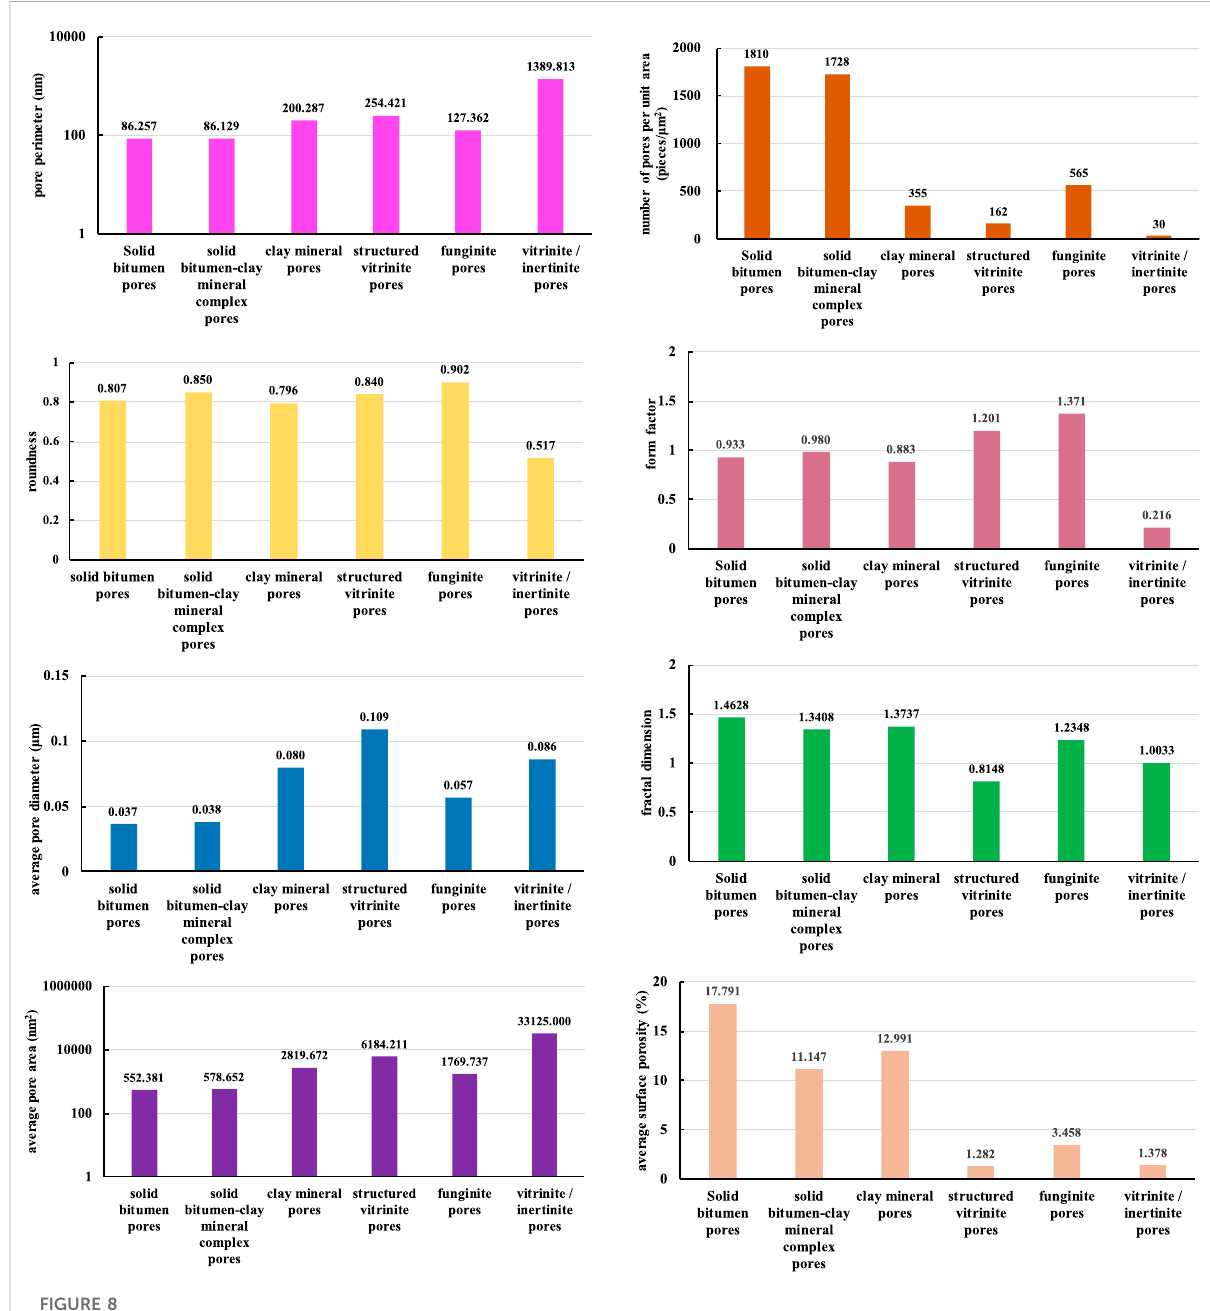
FIGURE 8 QuantitativecharacterizationofporecharacteristicsofshalewithdifferentmatricesinLianggaoshan FormationinWellTYX.SeeFigure1forthe well